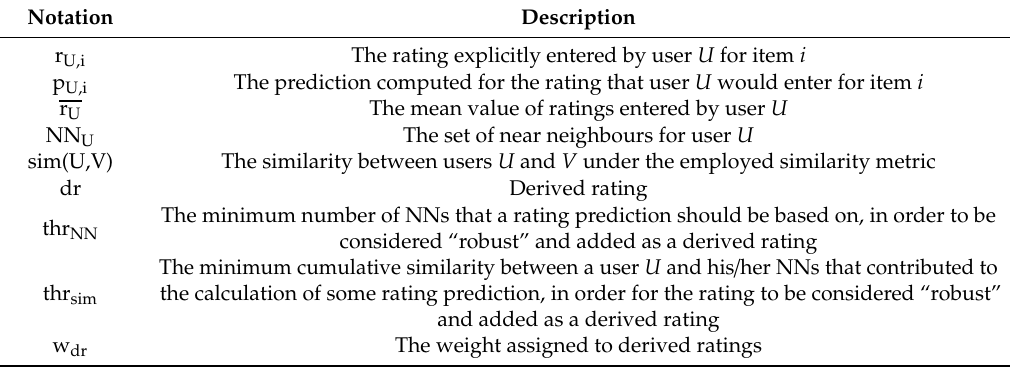
Table 3. Notations and concepts used in the CF DR